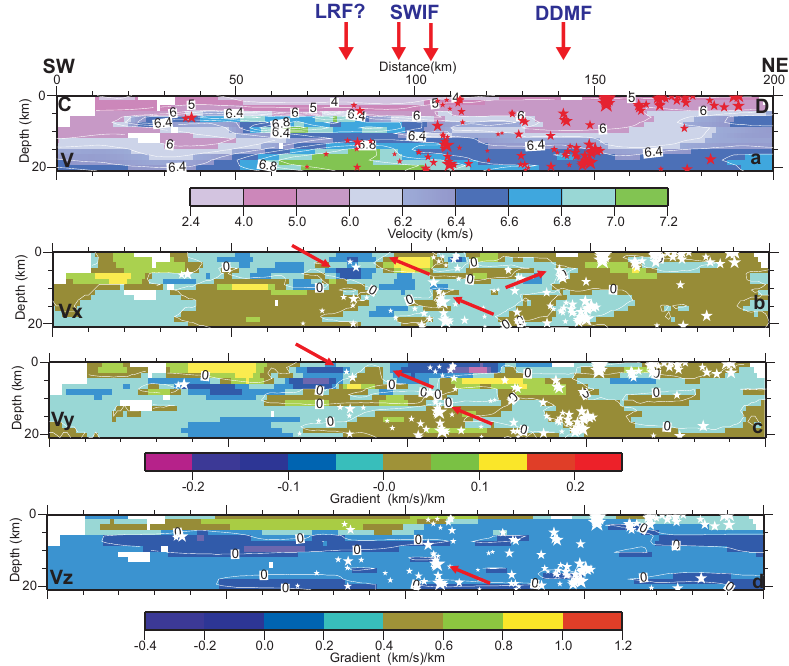
Fig. 3. Profile CD. Vertical cross-section of (a) tomographic velocity model (b) X gradient of velocity model, (c) Y gradient of velocity model, and (d) Z gradient of velocity model. Abbreviations as in Fig. 1.